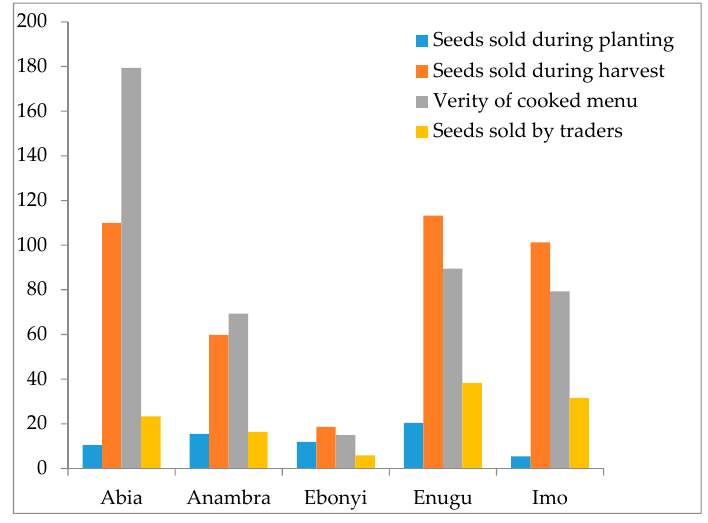
Figure 7. Income extractable from the sales of AYB in the five states of southeastern Nigeria (USD).